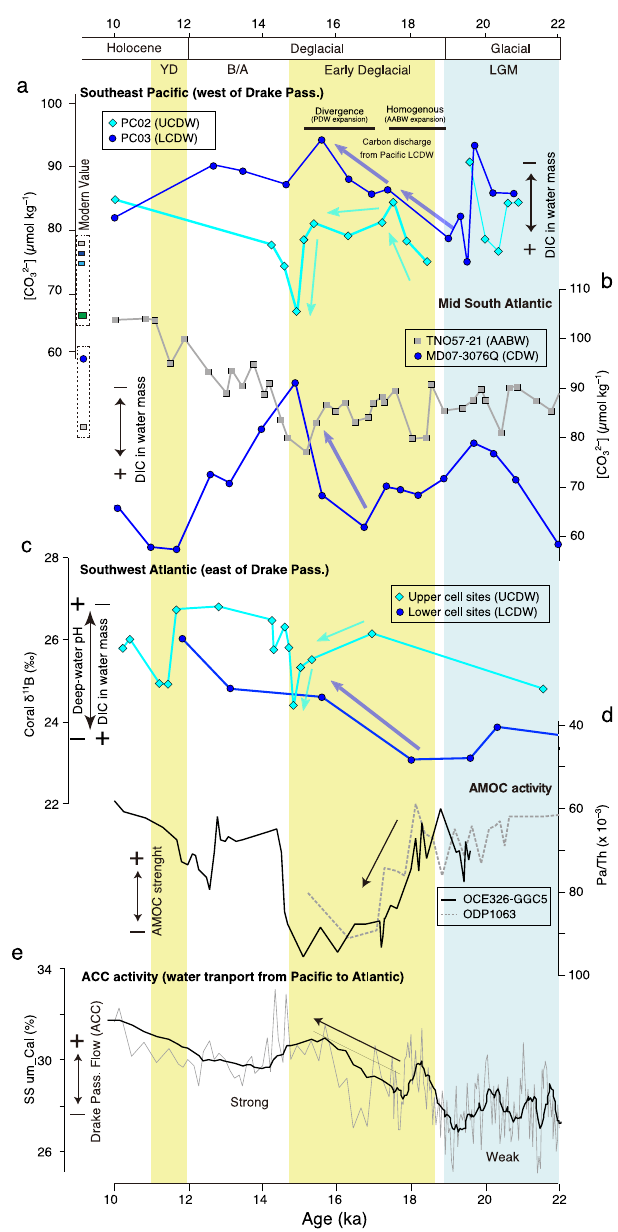
Fig.5|Deep-water[CO 3 2 − ]changeinstudyareacomparedtotherecordsinthe SouthAtlanticacrosstheDrakePassage.a Deep-water[CO 3 2 − ]reconstructionby XMCT scanning method in the SE Paci fi c (this study). b Deep-water [CO 3 2 − ] reconstruction by benthic foraminiferal B/Ca proxy in the Southern Atlantic 25 . c Deep-water pHreconstruction by deep-seacoral δ 11 B 56 . d Varianceof the Atlantic meridional overturning circulation (AMOC) strength shown by 231 Pa/ 230 Th 72,73 . e Variance of grain size in the sediment core at the Drake Passage, represents the strength of deep-water fl ow 55